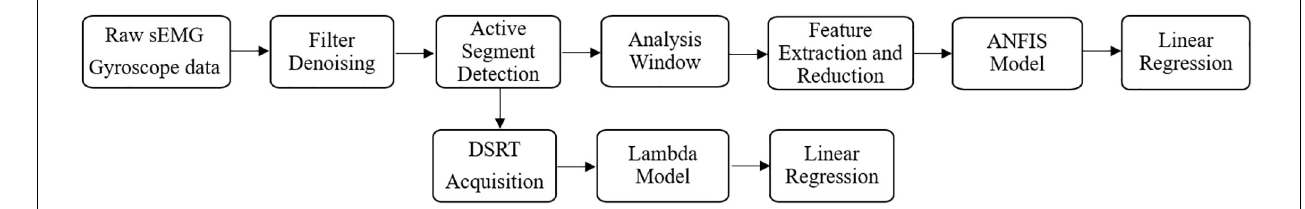
FIGURE 3 | Flowchart of the procedure for sEMG processing.